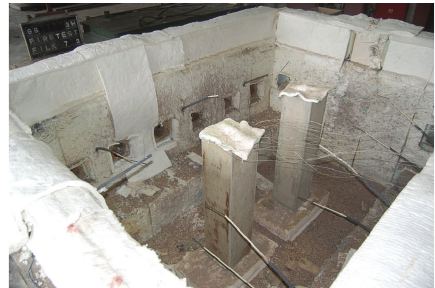
Figure 3: RC columns in furnace before fire test.